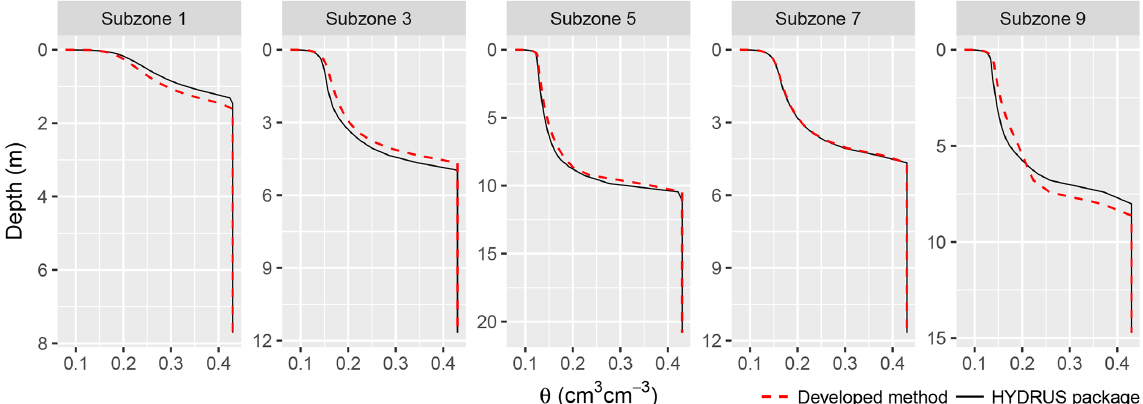
Figure 15. Comparison of water content profiles obtained from the HYDRUS package for MODFLOW (Seo et al., 2007) and the developed iterative feedback coupling method. Subzones 1, 3, 5, 7, and 9 are shown as an example. ( t = 365 days in case